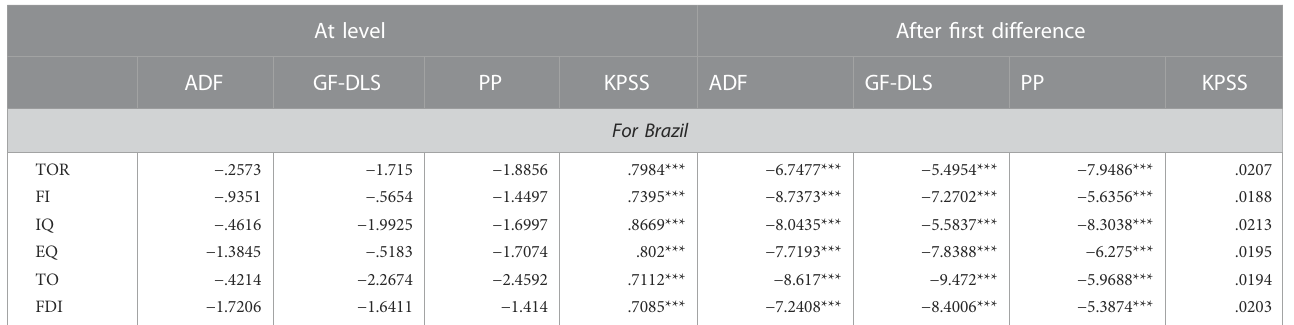
TABLE 4 Results of unit root test.